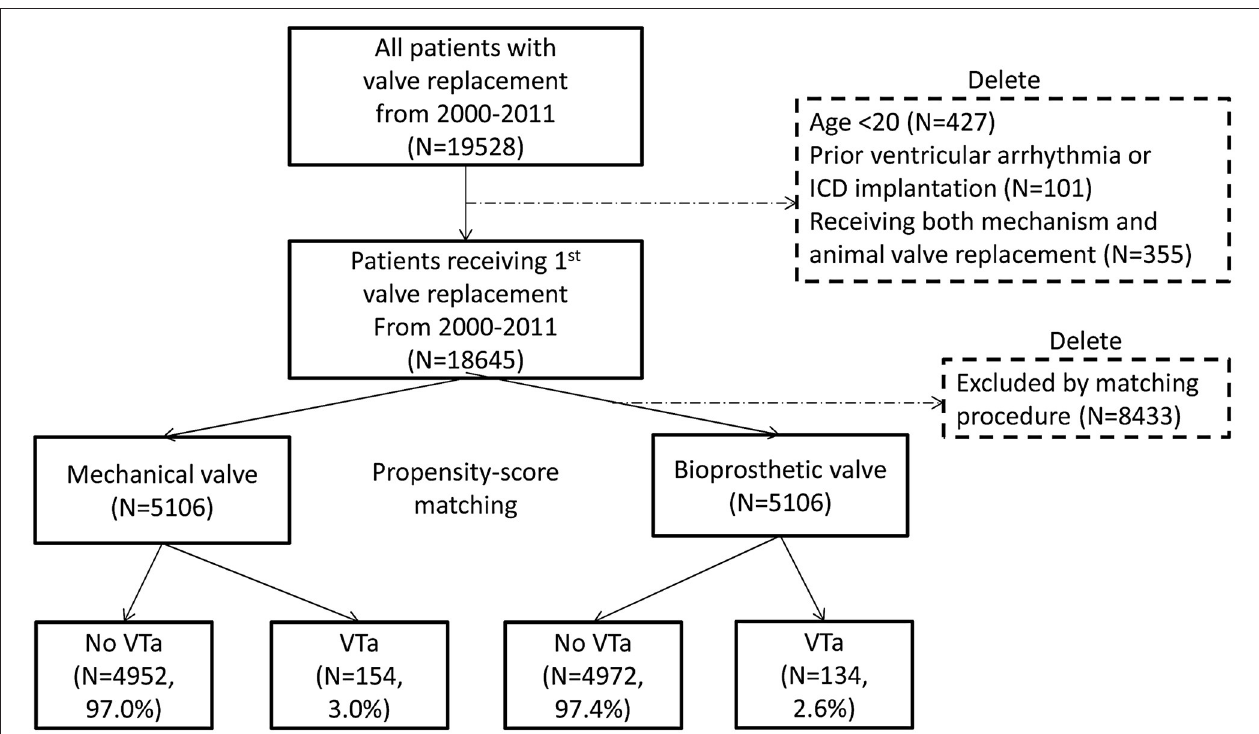
FIGURE 1 | Flow chart of the present study. The selection process of study population and propensity score matching is presented. ICD, implantable cardioverter-defibrillator; VTa, ventricular tachyarrhythmia.